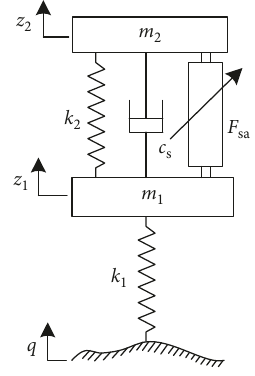
Figure 1: Quarter-vehicle